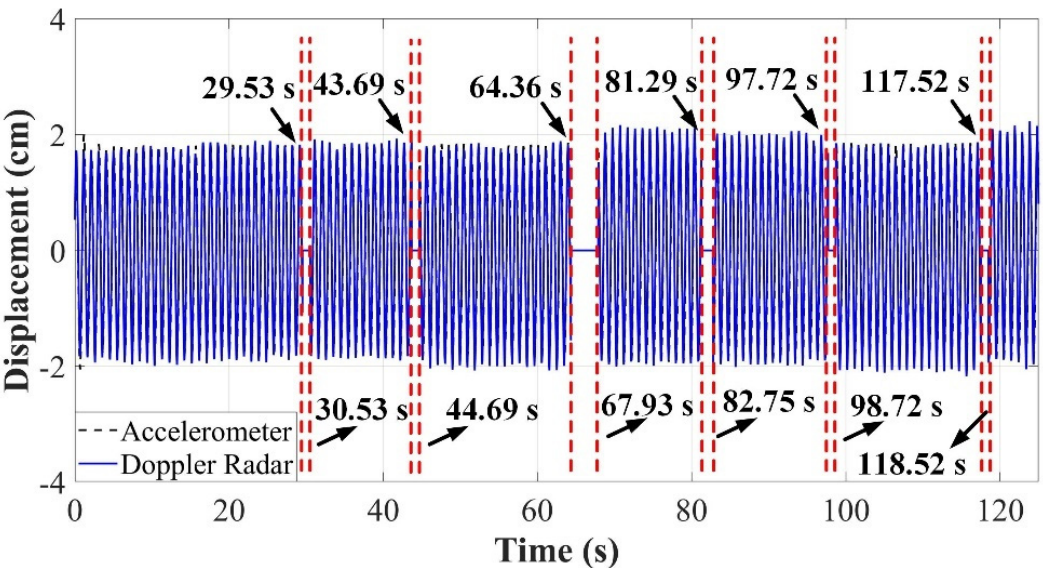
Figure 7. Displacement corrected by the proposed algorithm. The corrected portions of the retrieved radar-based displacement were successfully recognized.